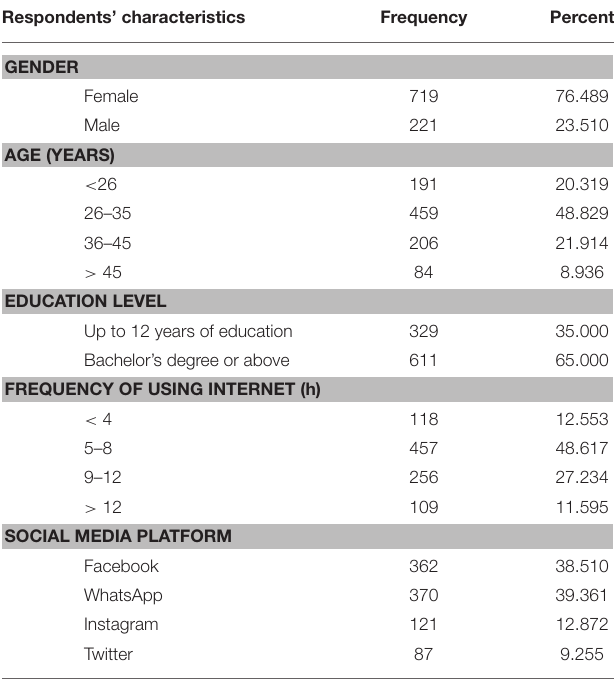
TABLE 1 | Respondents’